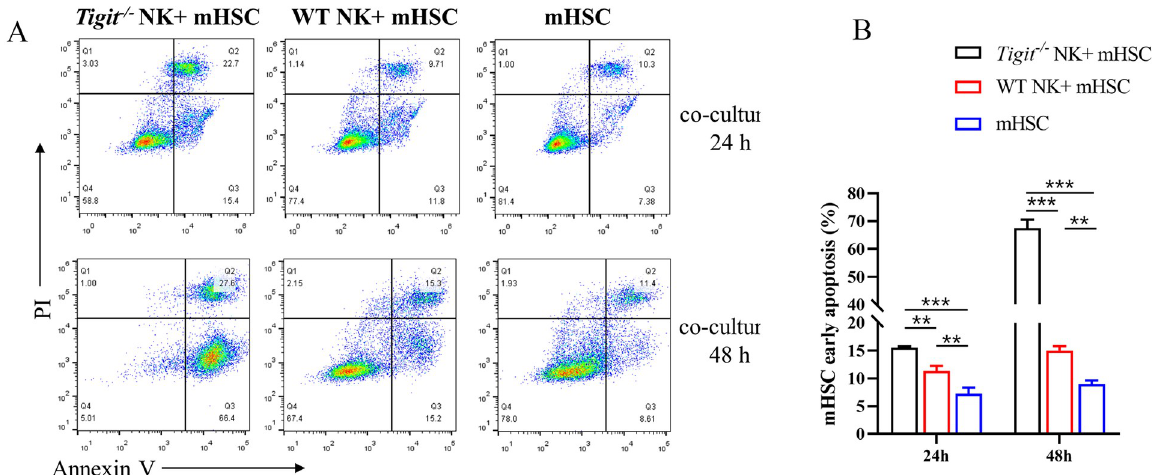
Fig 3. Tigit knockout enhanced natural killer (NK) cell killing activity on hepatic stellate cells (HSCs). (A) Flow cytometry scatter plots signifying mouse HSC (mHSC) apoptosis after co-culture with NK cells for 24 and 48 h. (B) Histogram of the percentage of apoptotic mHSCs after co-culture with NK cells for 24 and 48 h. All data are presented as mean ± standard deviation of at least three independent experiments. � P < 0.05, �� P < 0.01, ��� P < 0.001.